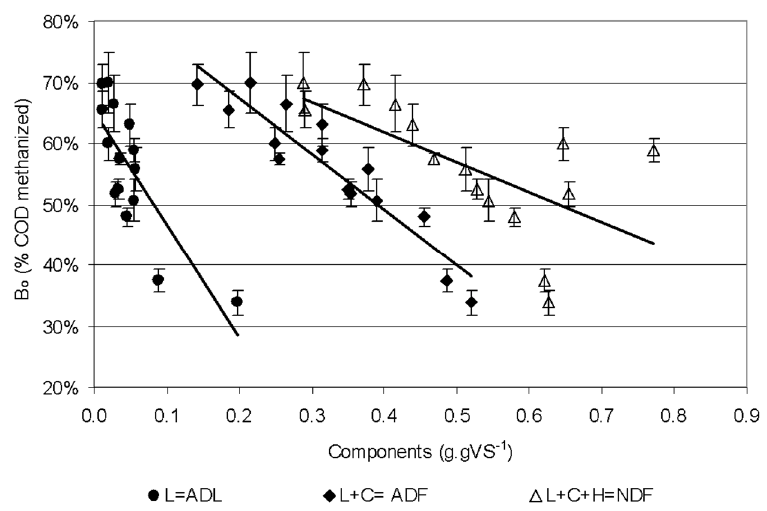
Figure 3. Percentage maximum methanized COD (B o ) in dependence of fiber components.